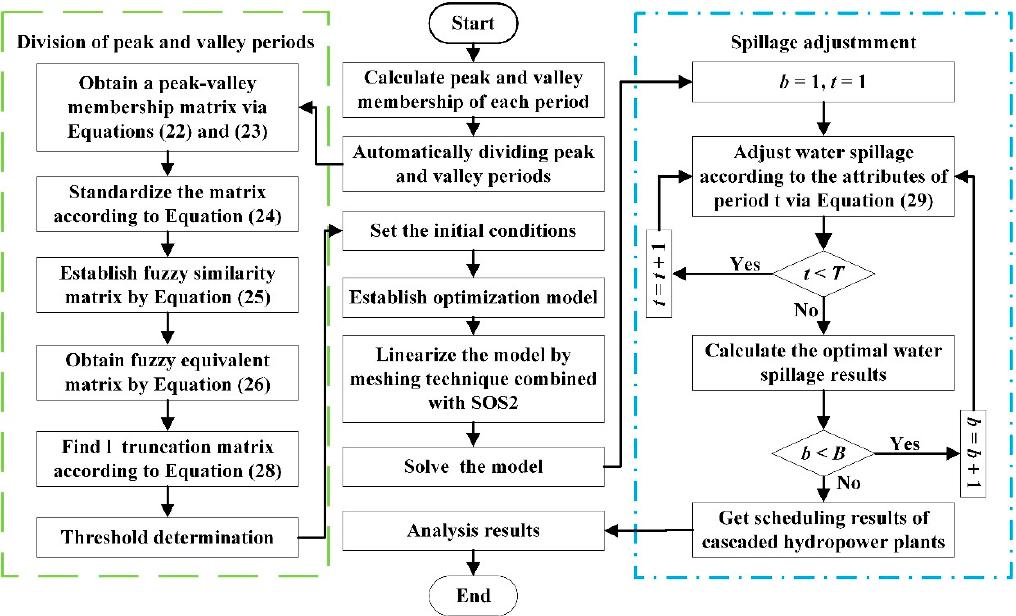
Figure 4. Overall solution process; SOS2 is a special ordered set of type two, T is the total number of periods, t is the period index, B is the total number of plants, and b is the plant index.